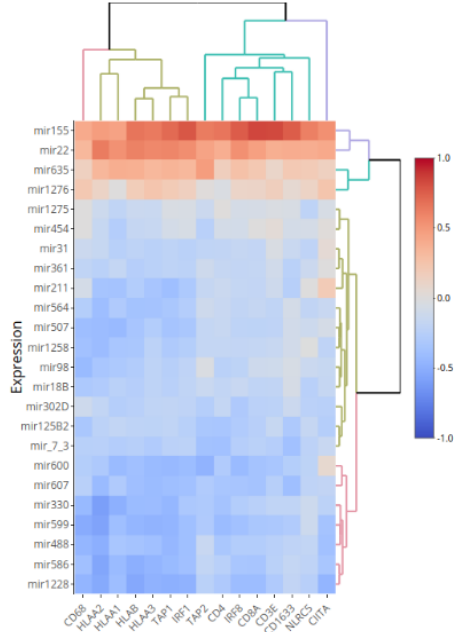
Figure 2. Heat map of the correlations between the expression levels of 24 miRNA expression with the mRNA expression of three HLA-A probes (probes HLA-A pr1, HLA-A pr2 and HLA-A pr3) and HLA-B, several regulators of HLA, members of the Antigen Loading Machinery, and T cell and macrophage markers. An analysis of 64 Uveal Melanoma was used to obtain the correlations. Red indicates a positive correlation and blue a negative correlation.